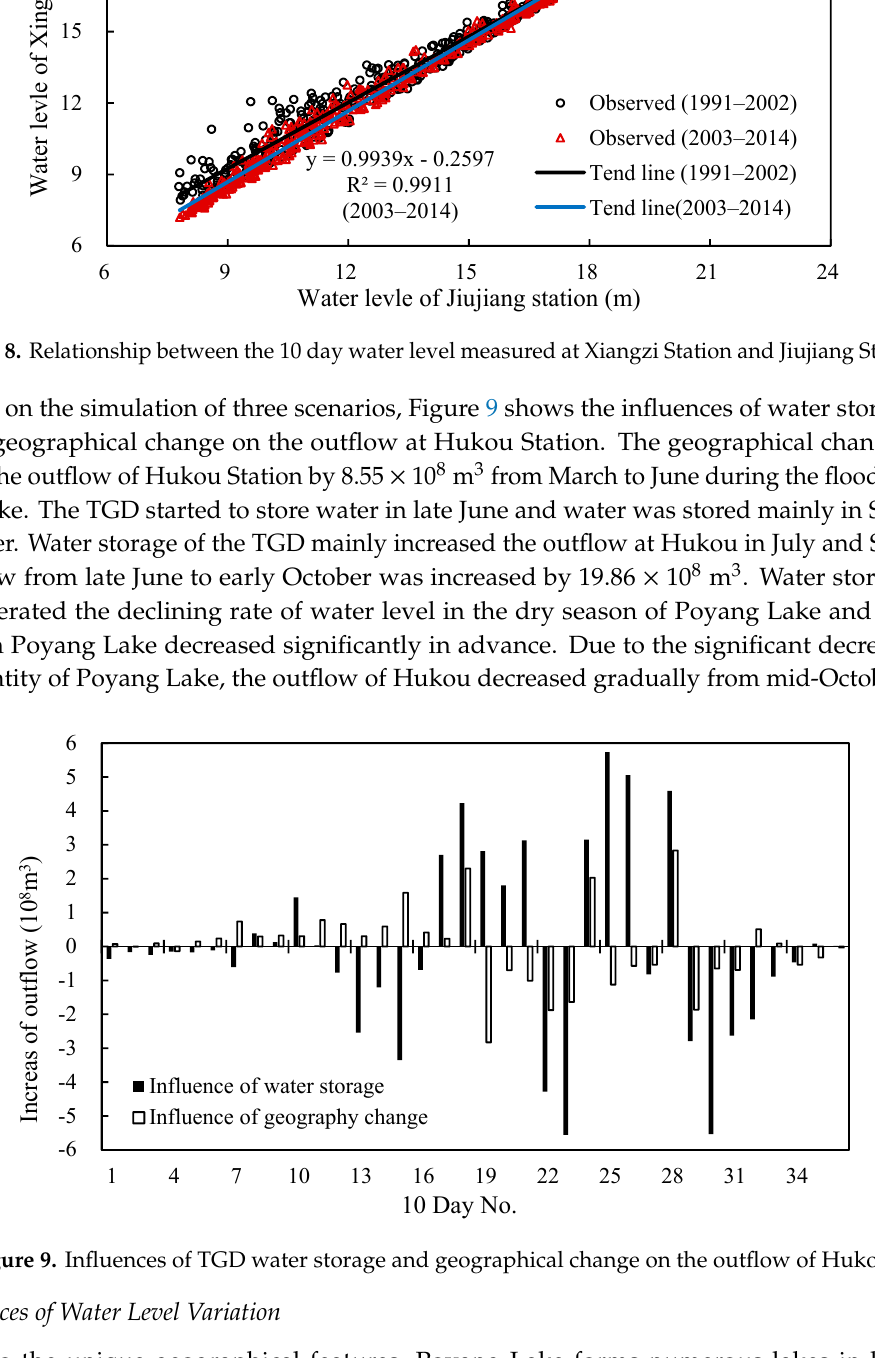
Figure 7. Water level–discharge curve of Jiujiang Station.